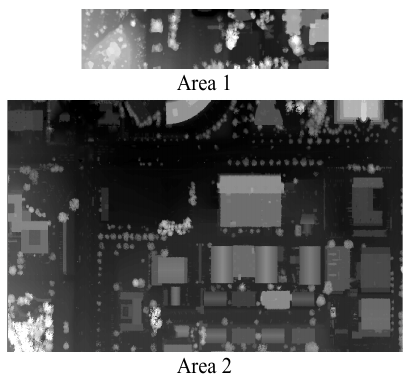
Figure 5. DSM of the Two Study Areas